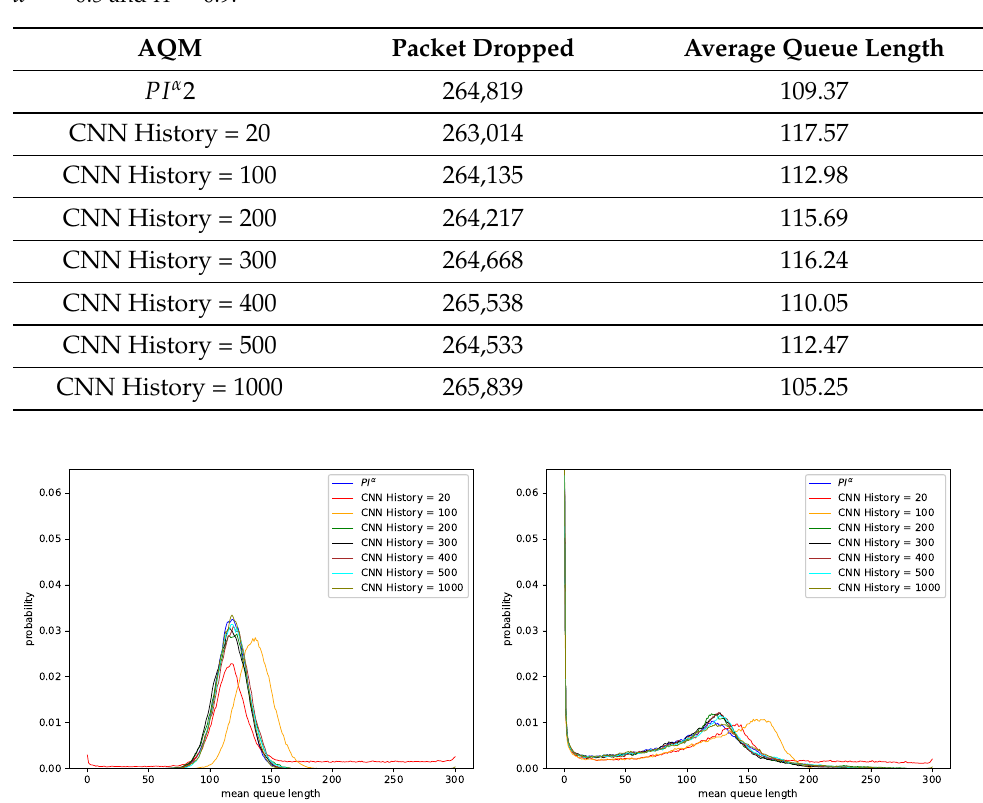
Table 11. Detailed results of queue occupancy obtained for CNN model with the last layer activation function Sigmoid, trained using data regarding PI α 2 controller parameters: K P = 0.0001, K I = 0.0004, α = − 0.5 and H = 0.9.